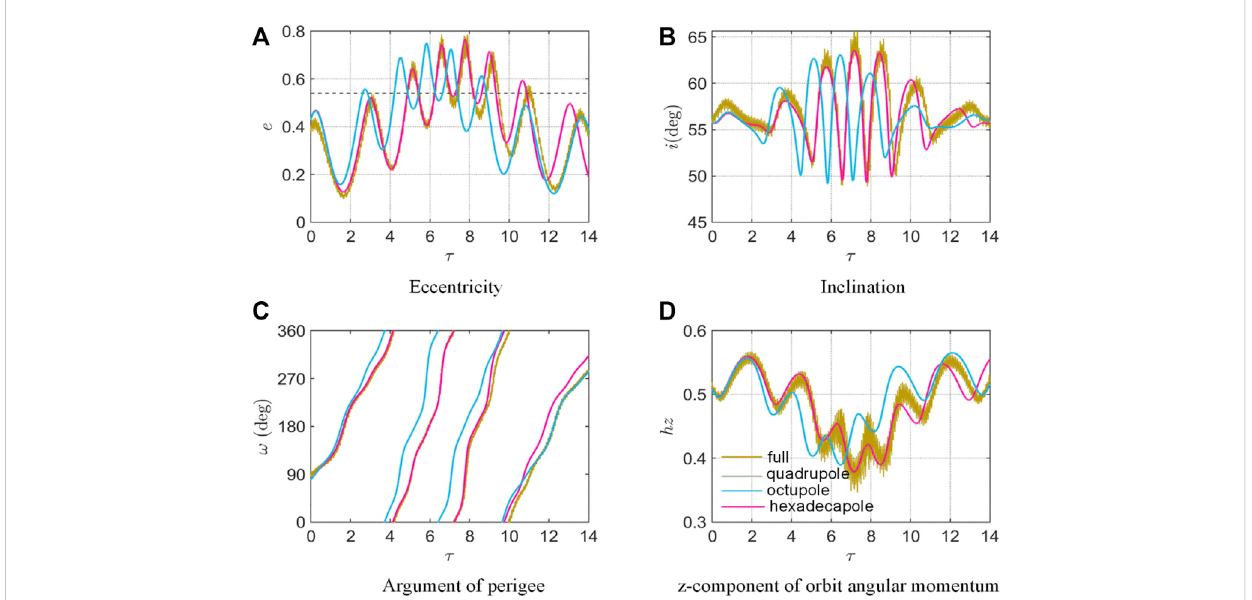
FIGURE 10 Long-term orbital evolution over 14 scaled time with e B (cid:2) 0 and i B (cid:2) 10 ° . The other initial conditions are set the same as Figure 9. The coef fi cients κ (cid:2) 1 . 53, ε (cid:2) 0, and ε (cid:2) 0 . 04. Since the octupole order coef fi cient ε Hex Oct (A – D) showthetemporalevolutionoftheeccentricity,inclination,argumentofperigee,andz-componentoftheorbitangularmomentum,respectively.